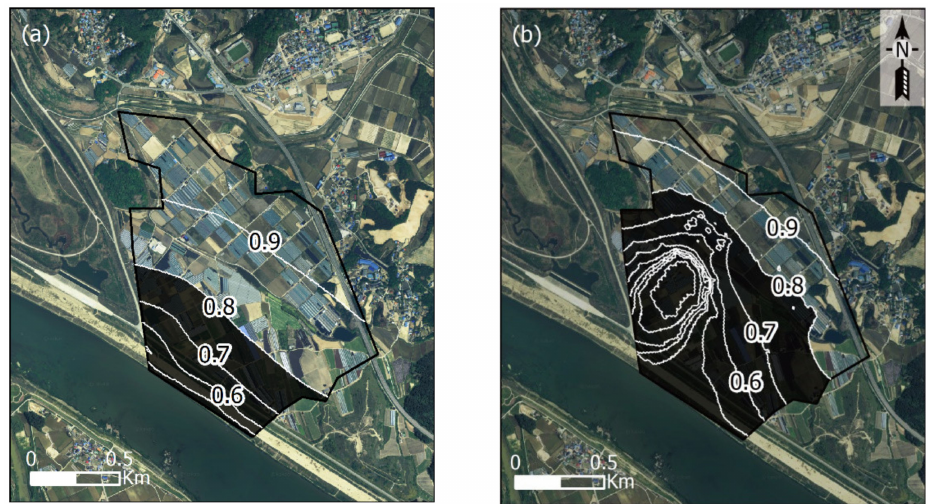
Figure 10. Areas in which aquifer productivity decreased due to opening of the weir, incorporating spatial variations of API values less than 0.8 (shaded area), during ( a ) non-seasonal and ( b ) seasonal pumping